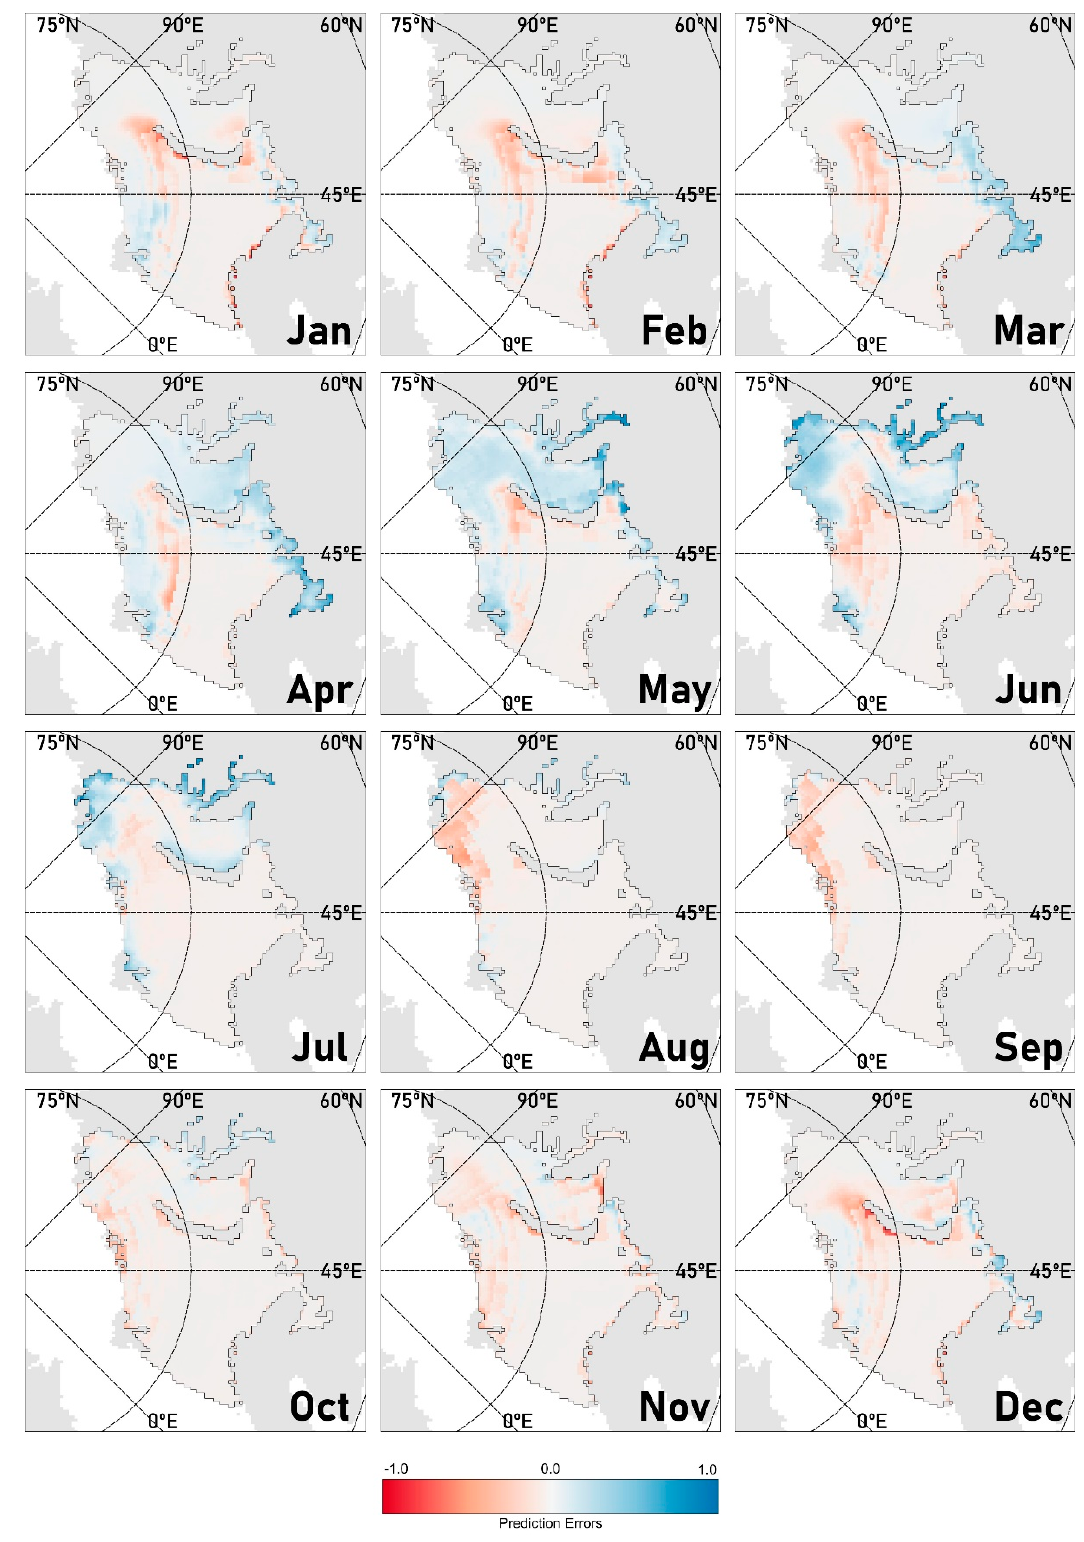
Figure 9. Errors of monthly averages of sea ice concentration predicted by the DNN with BMA2 ensemble for the Kara and Barents Seas during 2006–2016.